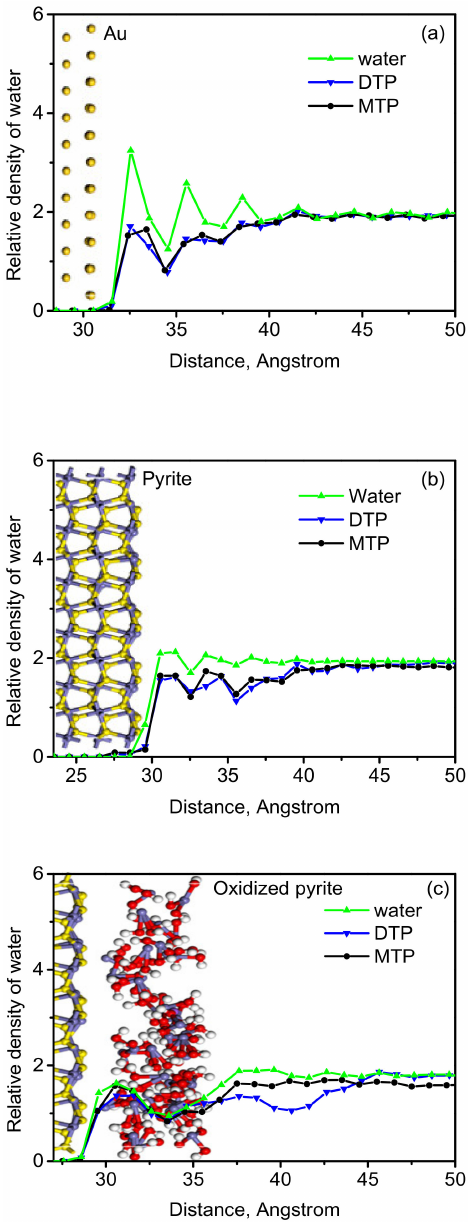
Figure 4. Relative number density distribution of water along the normal to the Au (111) ( a ), pyrite (100) ( b ), and oxidized pyrite (100) ( c ) surfaces with and without DTP/MTP. Fe(OH) 3 : dark grey: iron; white: hydrogen; red: oxygen. Pyrite: yellow: sulfur; purple: iron. Gold: dark yellow: